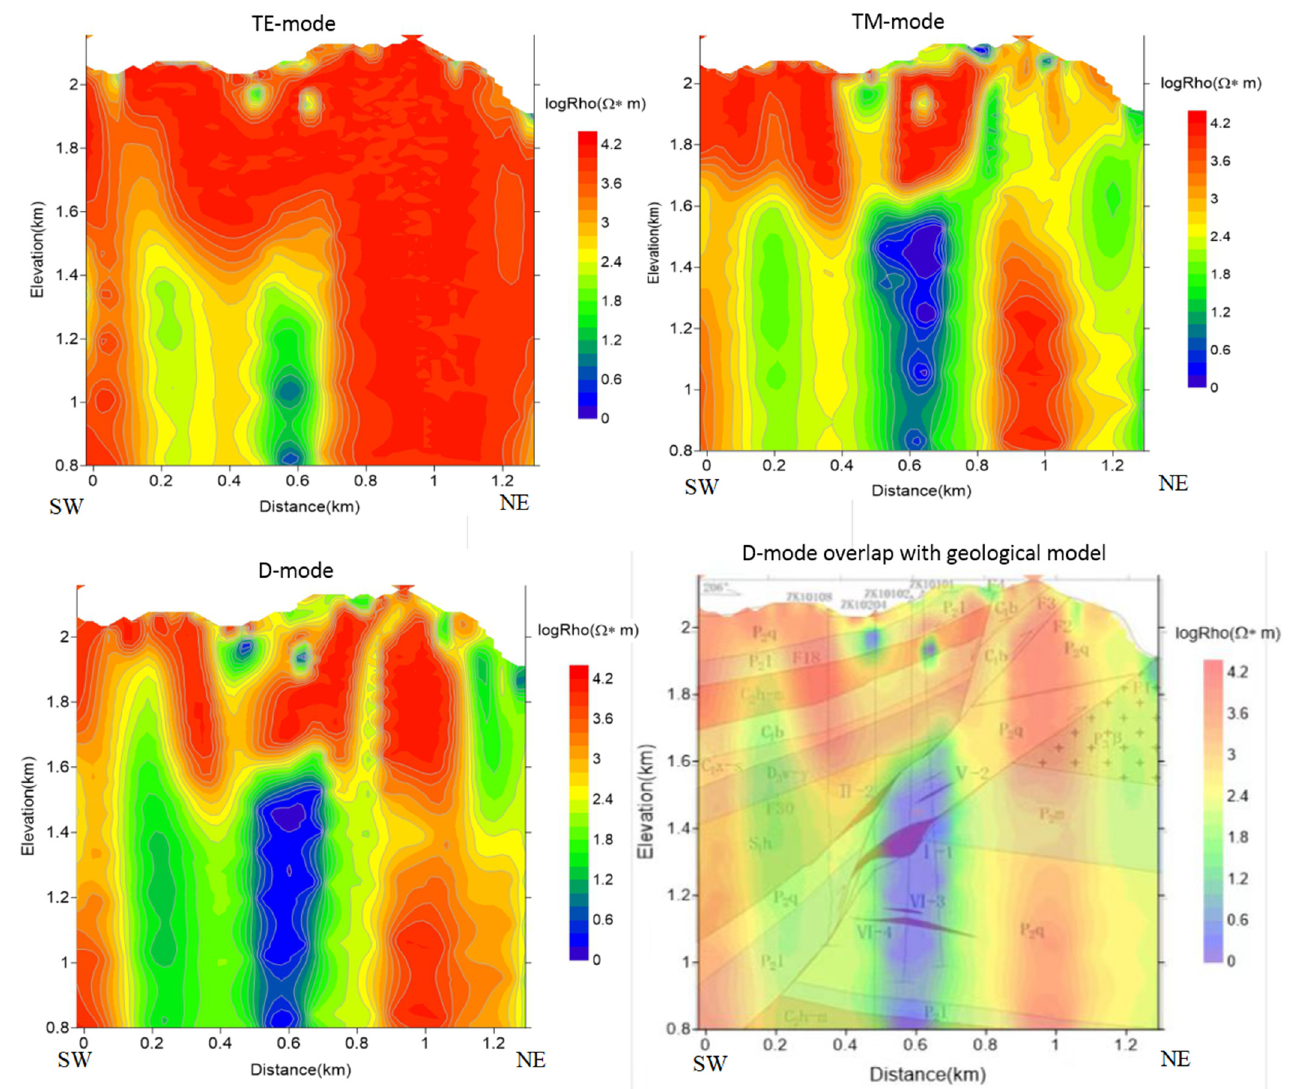
Figure 9. 2D inversion models of AMT data resolved by TE mode, TM mode, and D mode, obtained by ZondMT2D focused inversion and the overlap of the D ‐ mode model with the geological model from Figure 3b. TE mode RMS =18.1%. TM mode RMS=9.7%. D ‐ mode RMS=9.1%.